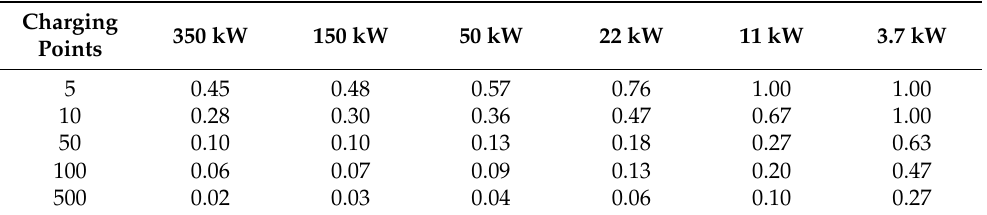
Table A6. Demand factors for the area type “Rural Region: Medium-sized City, Urbanized Area” and six charging powers.